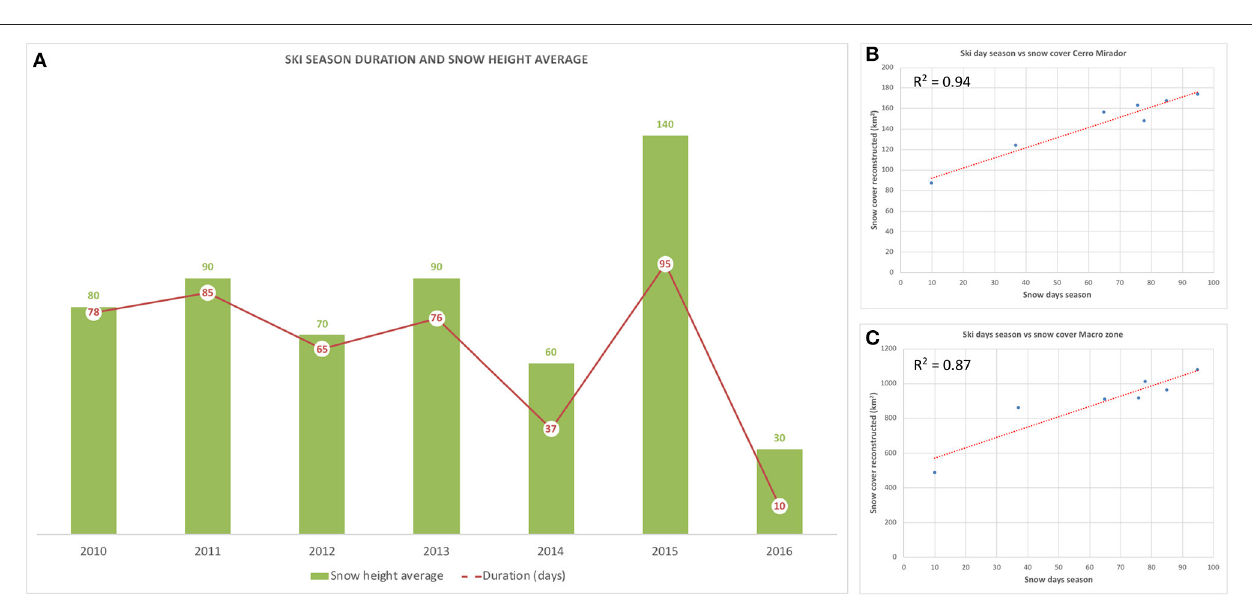
FIGURE 10 | Ski season duration and snow height average. (A) shows the relationship between the ski season duration and the average snow height measured at Club Andino. (B,C) display the correlation between the duration of the ski season and the monthly averaged NDSI-reconstructed snow cover from June-August (average of of the ski season period), for the Cerro Mirador and Macro zone, respectively. Both correlations are significant at the 95% confidence level.